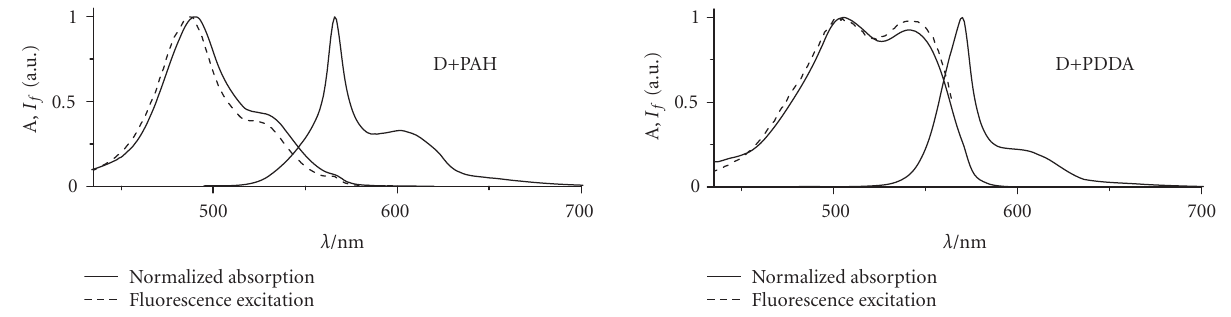
Figure 2: Normalized absorption (solid), fluorescence excitation (dashed), and emission spectra of cyanine D in PAH and PDDA solutions (same concentrations as for Figure 1); λ exc = 490 nm (PAH) and 470nm (PDDA); λ em = 610 nm (PAH) and 570nm